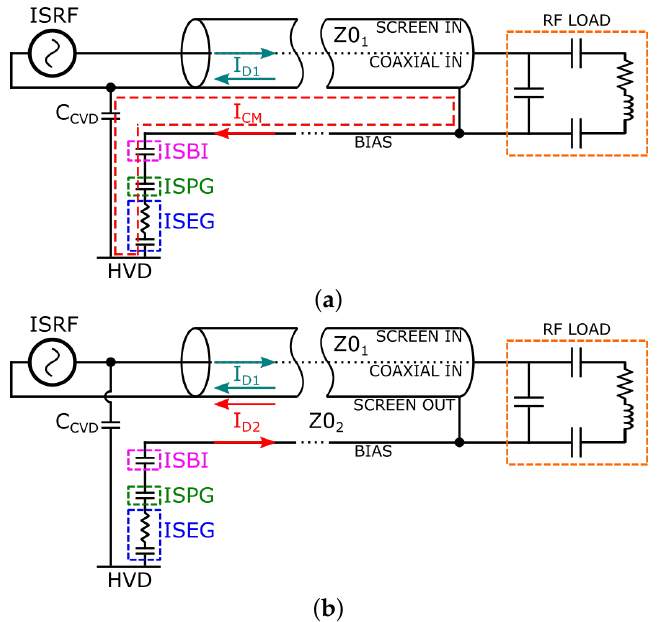
Figure 4. RF stray current paths with CVD installed at RF transformer primary side. ( a ) Common mode current related to the connection of one CVD leg to the outer conductor of the RF coaxial line. ( b ) Differential mode current related to the connection of one CVD leg to the inner conductor of the RF coaxial